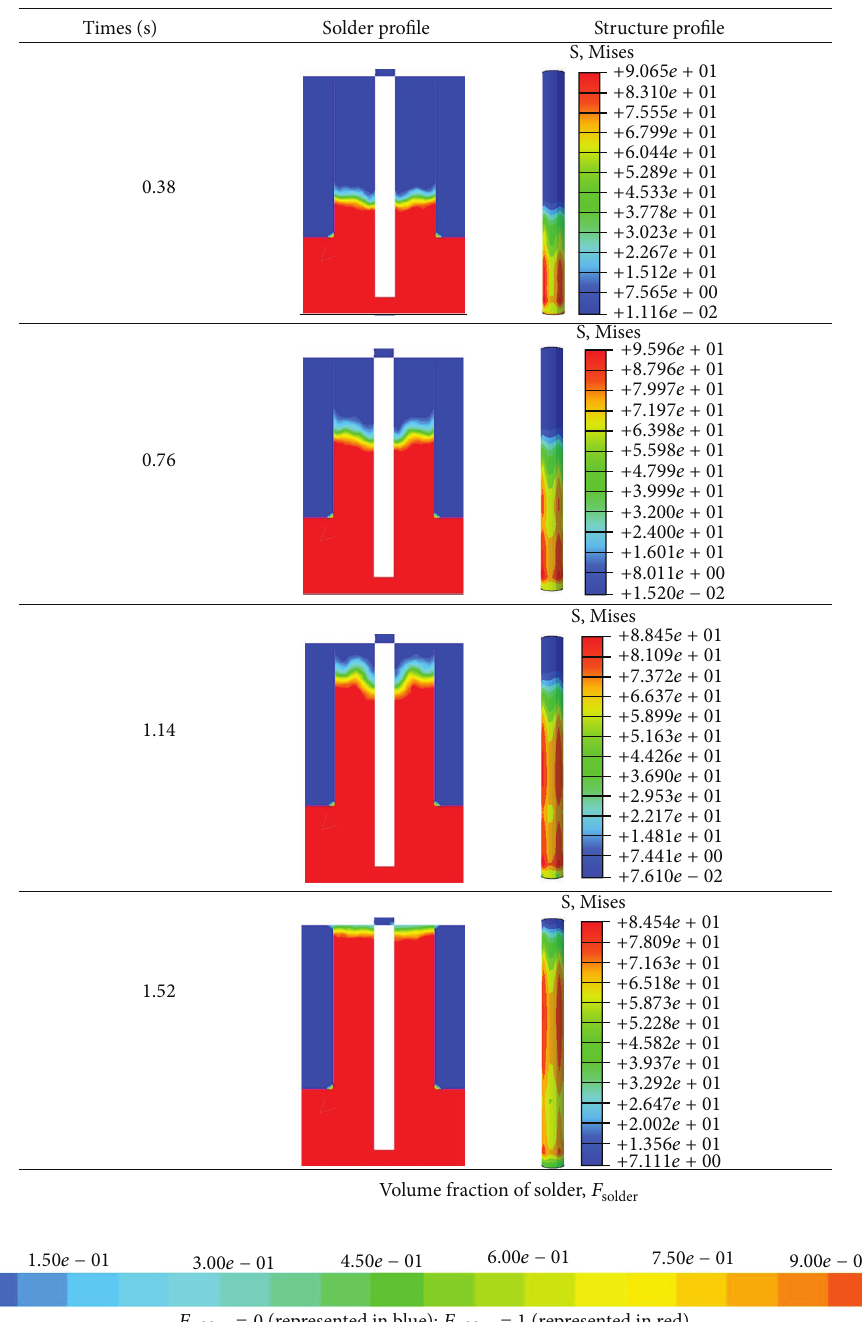
Figure 10: Overview of